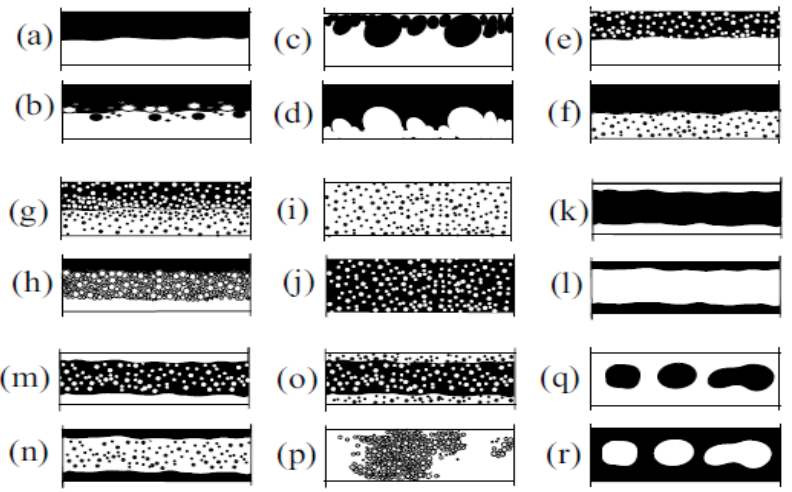
Figure 2. Typical flow patterns of oil-water in horizontal pipes [2]. Note: ( a , b ) Stratified flow of two separated layers (S, possibly with mixing at the interface, SM). ( c , d ) Stratified layers of a free-liquid and a dispersion of the other liquid (e.g., oil-in-water dispersion above a water layer, Do / w & w). ( e , f ) Stratified layers of a free liquid and a dispersion in the other liquid (e.g., oil and oil-in-water dispersion, Do / w & o; water and water-in-oil dispersion, Dw / o & w). ( g , h ) Layer of dispersions (e.g., water-in-oil dispersion above oil-in-water dispersion Dw / o & o / w, possibly with pure oil at the top and / or water at the bottom). ( i , j ) Fully dispersion or emulsion of one liquid in the other liquid (e.g., water-in-oil or oil-in-water dispersion or emulsion, Dw / o or Do / w). ( k , l ) Core-annular flow—a core of one liquid with the other liquid (e.g., a core of viscous oil and water in the annulus, ANw. Oil in the annulus, ANo). ( m , n ) Annular flow of a liquid with a dispersion in the core (water in the annulus DANw, oil in the annulus DANo). ( o ) Core-annular flow of two dispersions (CADw or CADo). ( p ) Intermittent flow (one liquid alternatively occupying the pipe as free liquid or as a dispersion, Io or Iw). ( q , r ) Larger elongated or spherical bubbles of one liquid in the other (SLo, Bo or SLw, Bw) [2].